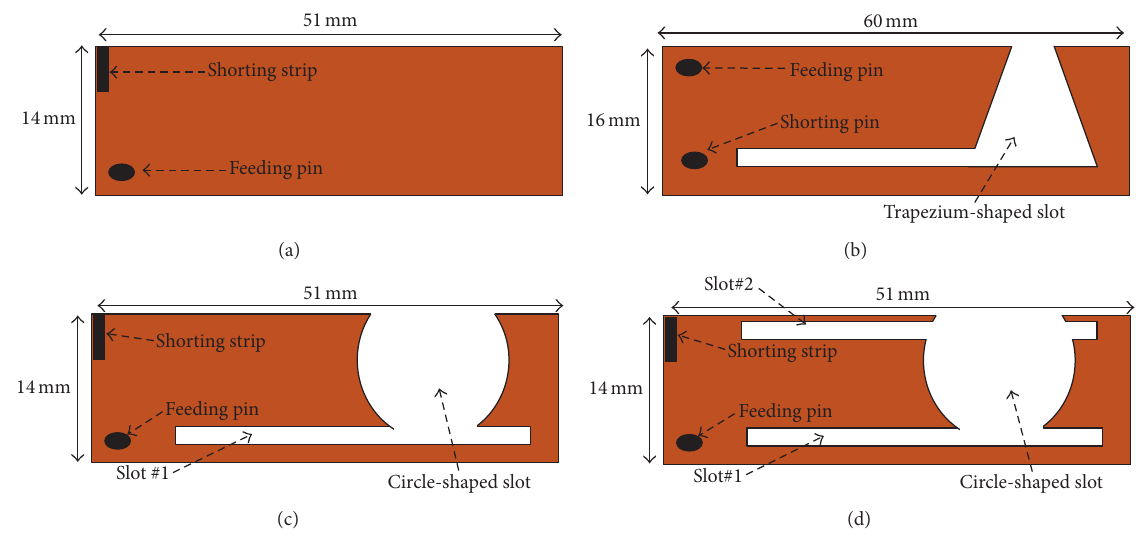
Figure 2: The evolution steps of the proposed PIFA: (a) Ant1, (b) Ant2, (c) Ant3, and (d) Ant4.